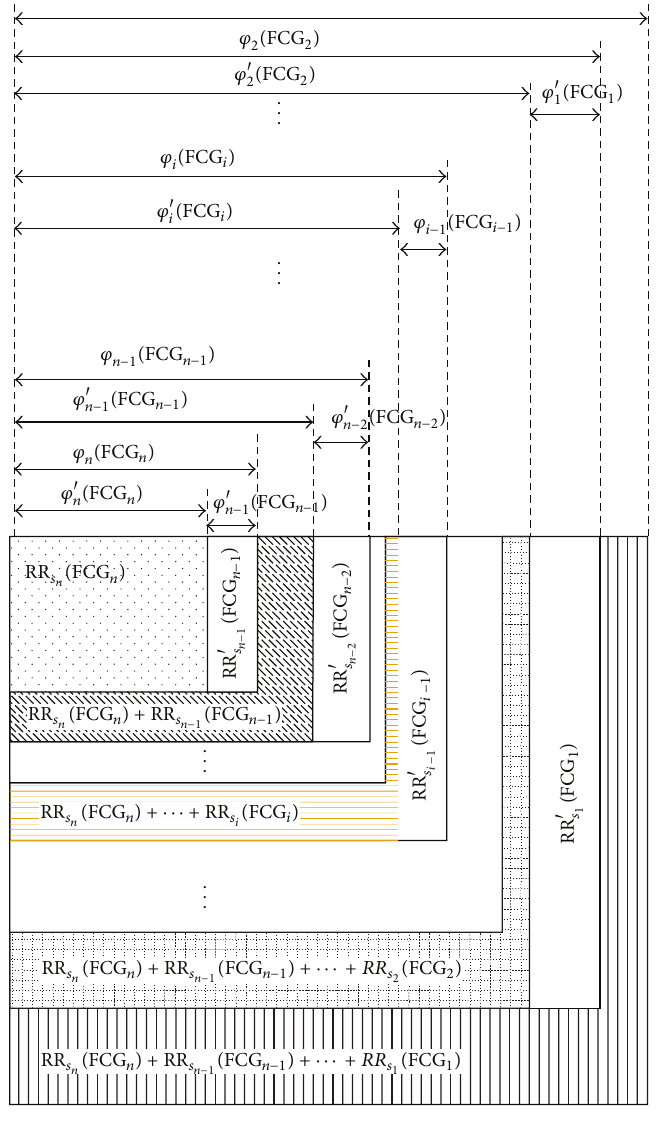
Figure 2: Generalized